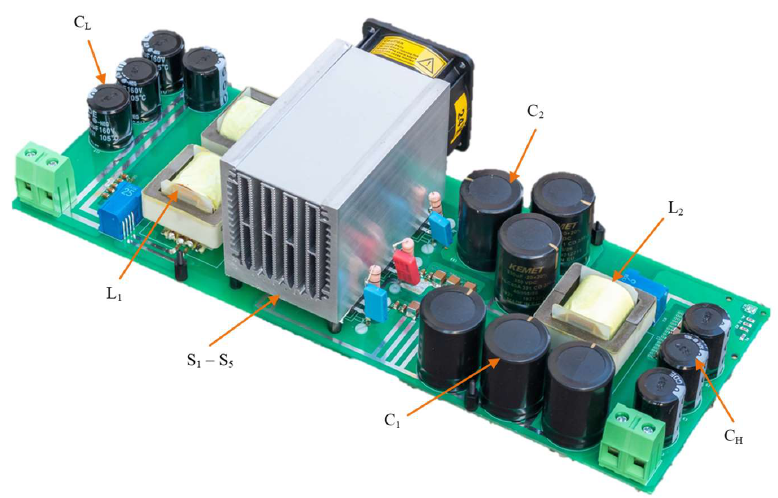
Figure 23. BHSC prototype. Table 4. BHSC prototype parameters.